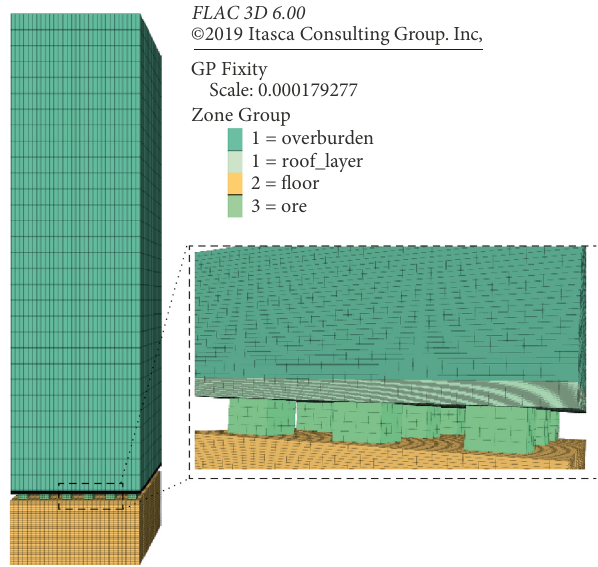
Figure 4: Simulation model in process.